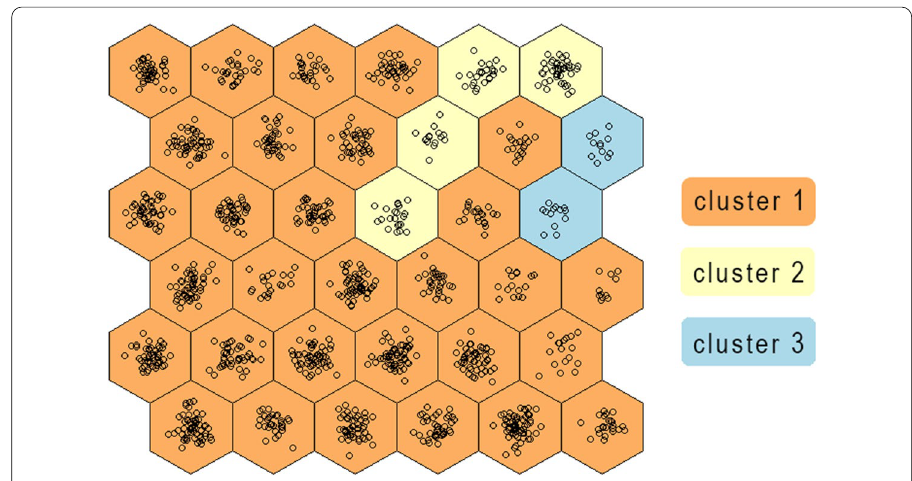
Fig. 15 Kohonen map with clusters of